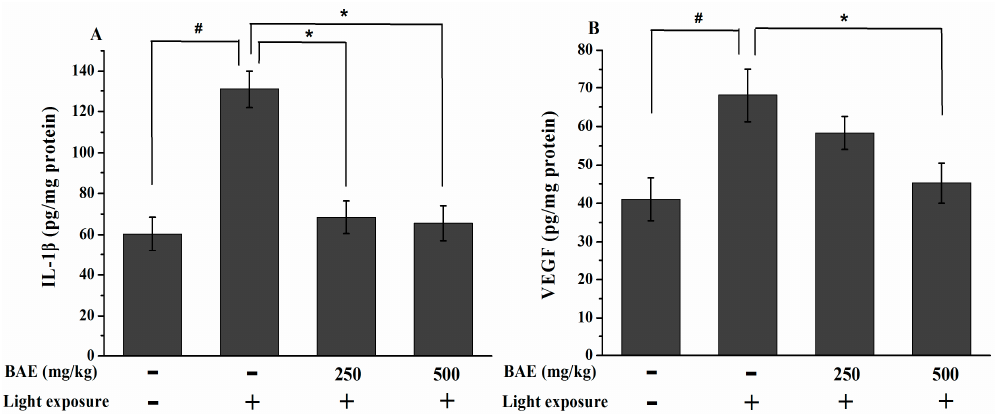
Figure 6. Changes in ( A ) IL-1 β and ( B ) VEGF levels in the retina at 7 days after light exposure (18,000 lx). Data are expressed as the mean ± standard deviation ( n = 8). #, * p < 0.05 ( t -test). IL-1 β : interleukin-1 β ; (18,000 lx). Data are expressed as the mean ˘ standard deviation ( n = 8). #, * p < 0.05 ( t -test). IL-1 β : VEGF: vascular endothelial growth factor. interleukin-1 β ; VEGF: vascular endothelial growth